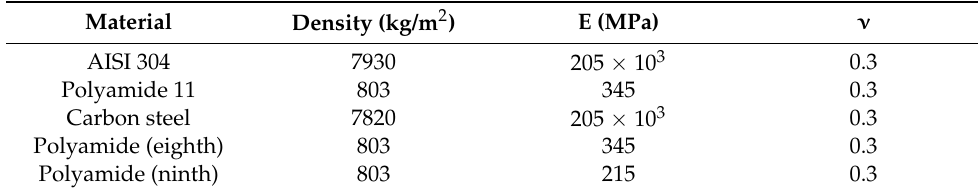
Table 3. Material parameters.